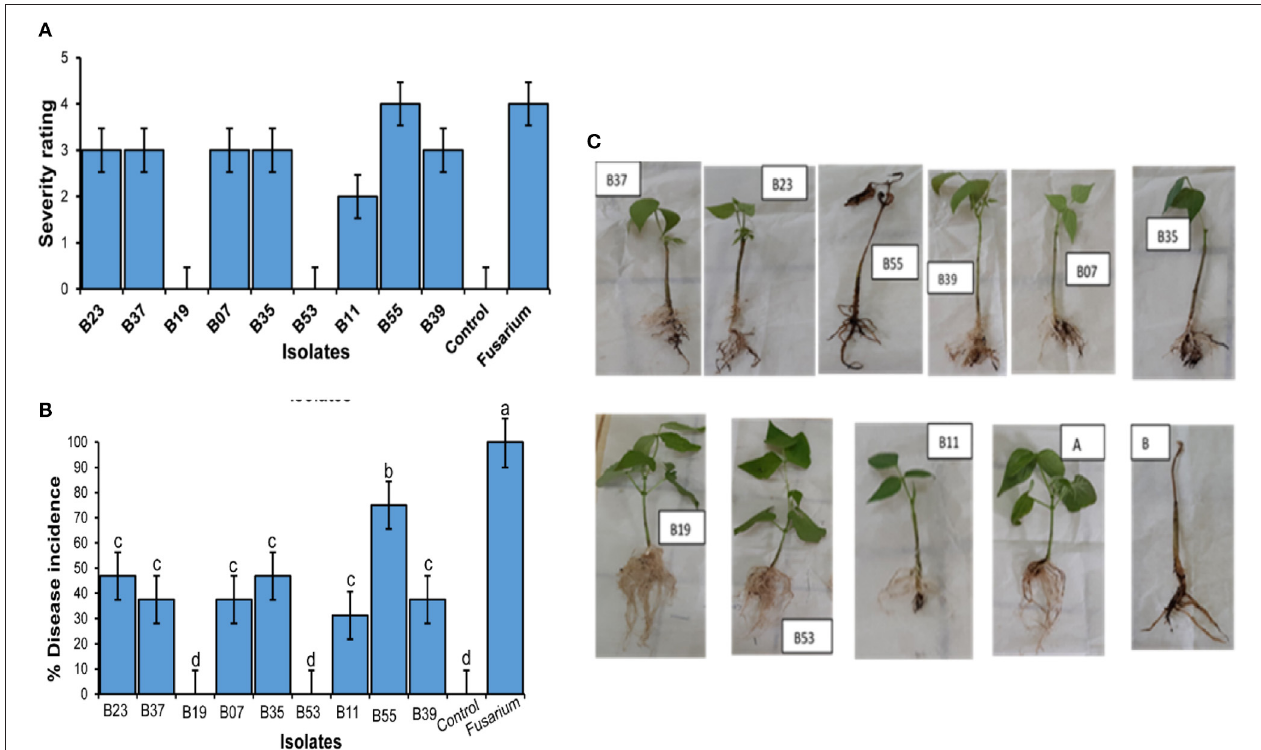
FIGURE 5 | Effect of endophytic colonization of beans by bacterial endophytes on Fusarium solani. (A) Severity of symptoms in the bean root system in Fusarium solani- infected soil and endophytes B53 ( Bacillus megaterium ), B19 ( Enterobacter hormaechei subsp. Xiangfangensis ), B37 ( Bacillus tequilensis ), B07 ( Bacillus subtilis ), B35 ( Bacillus velezensis ), B11 ( Bacillus subtilis subsp. spezizenii) , B39 ( Bacillus aerius ), B23 ( Bacillus australimaris ) and B55 ( Alkalihalobacillus clausii ). (A) Represents control seedling without endophyte and grown in un-infested soil. (B) Represents control seedlings without endophytic bacteria and grown in Fusarium solani infested soil. All plants were grown in a greenhouse for 30 days. (B) Percentage ( ± SEM) of disease incidence. Bars with different letters indicate significant difference (ANOVA, then SNK post-hoc , p < 0.05). (C) Severity rating of diseases ( ± SEM).